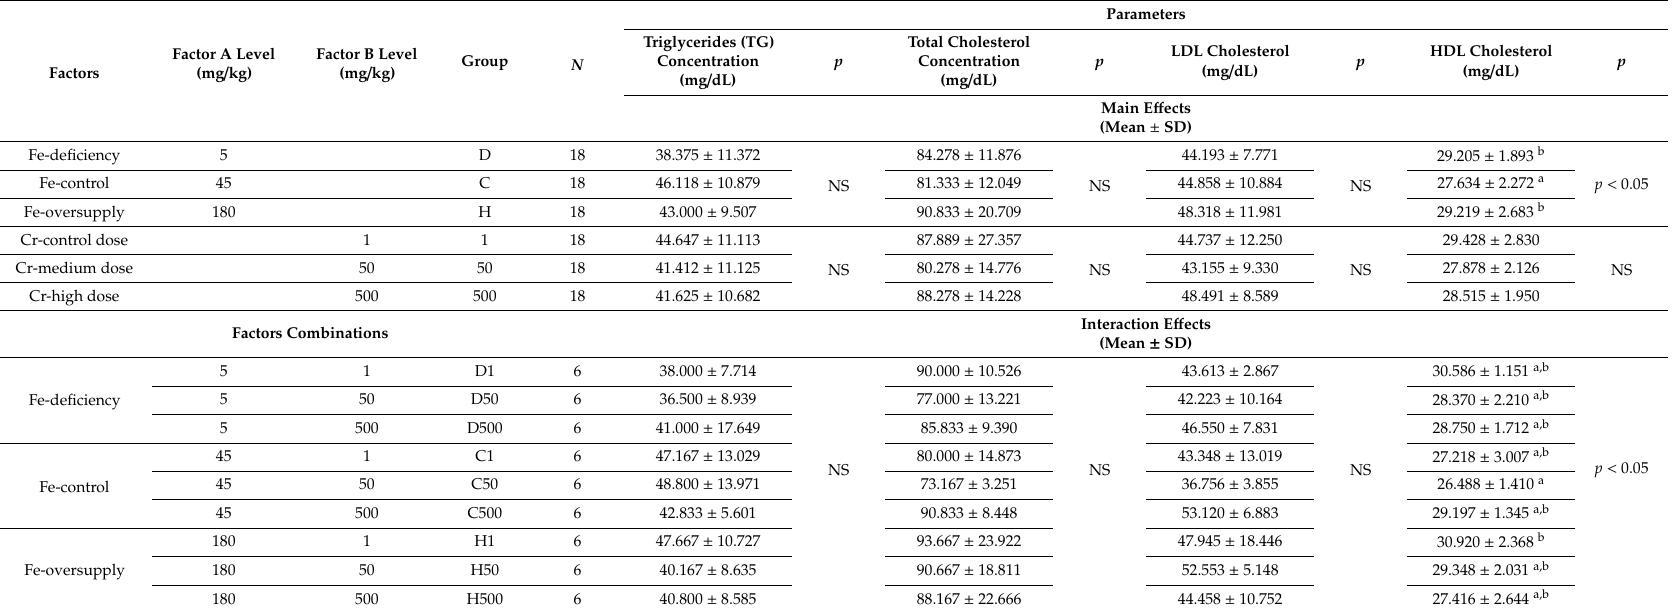
Table 6. The e ff ects of the Fe(III) and Cr(III) levels in the diet on the lipid profile in